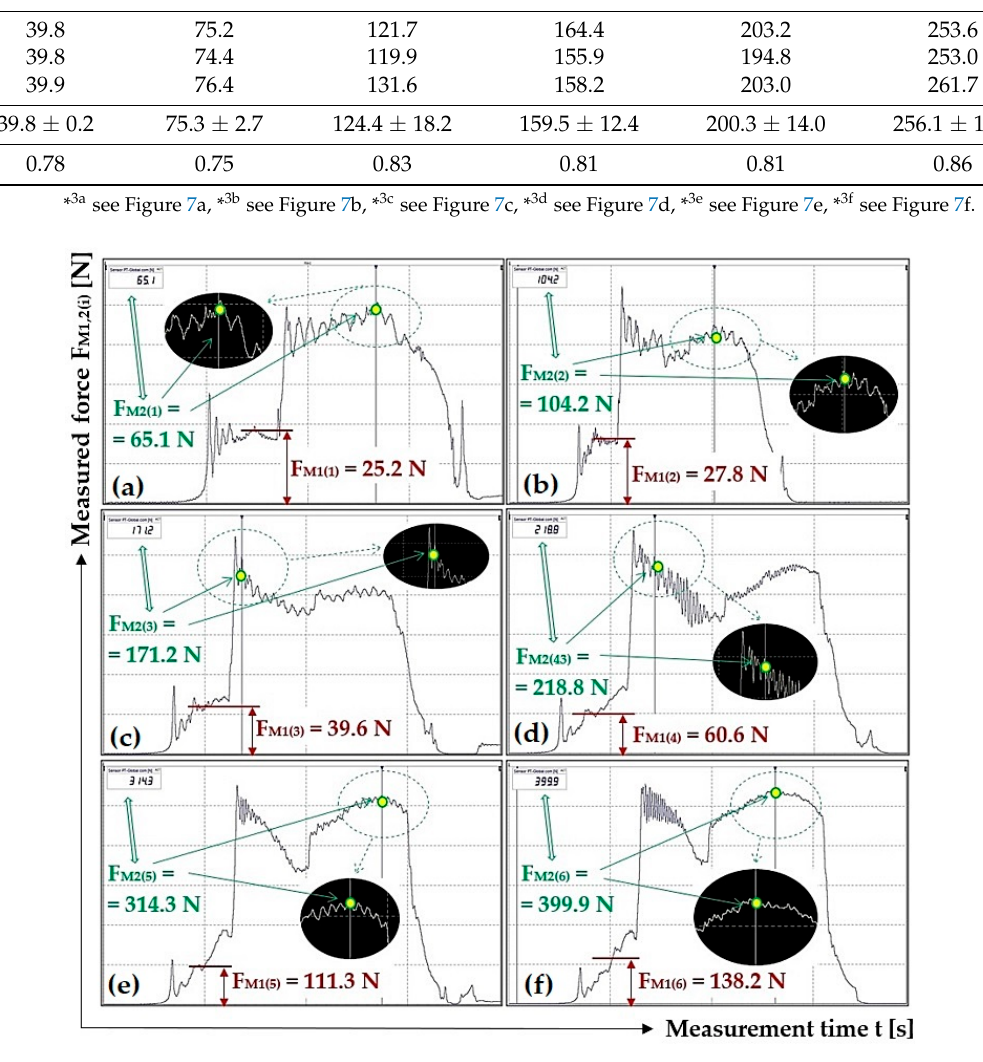
Table 4. Measured force F M1(i) [N] and F M2(i) [N] for the weight of the load G b(i) [N] at angle β = 20 deg.